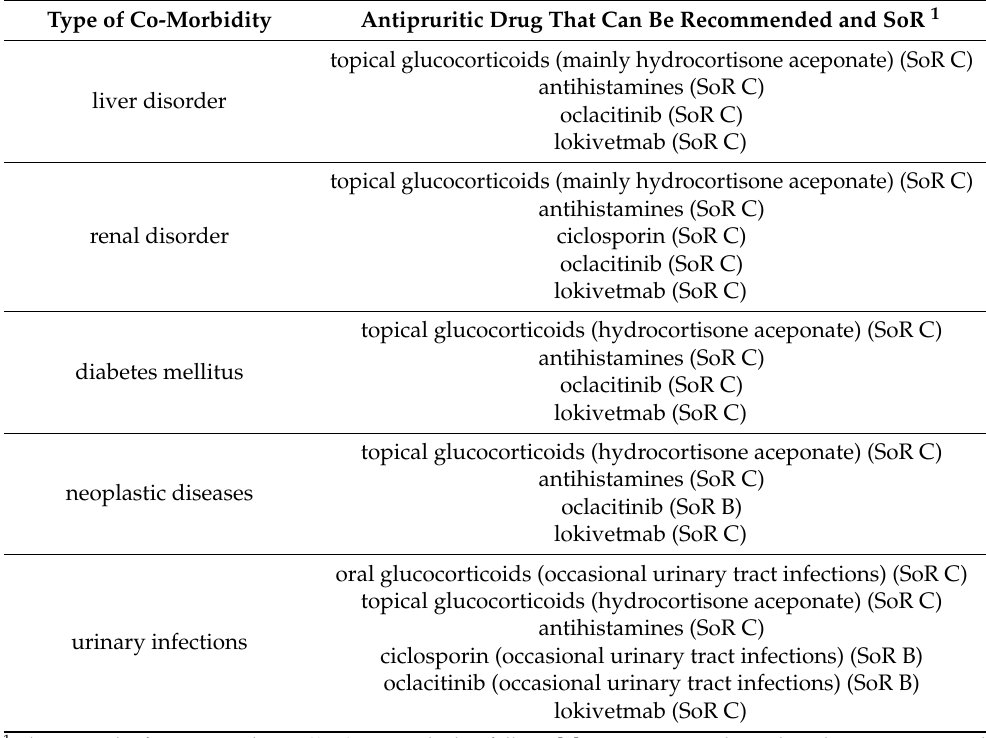
Table 9. Summary of antipruritic drugs that may be used in atopic dogs with co-morbidities. Type of Co-Morbidity Antipruritic Drug That Can Be Recommended and SoR 1 topical glucocorticoids (mainly hydrocortisone aceponate) (SoR C) liver disorder